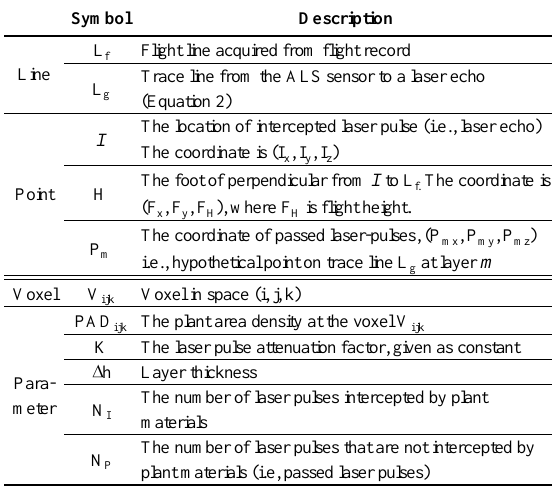
Table 1. Nomenclature used in Section 2.3